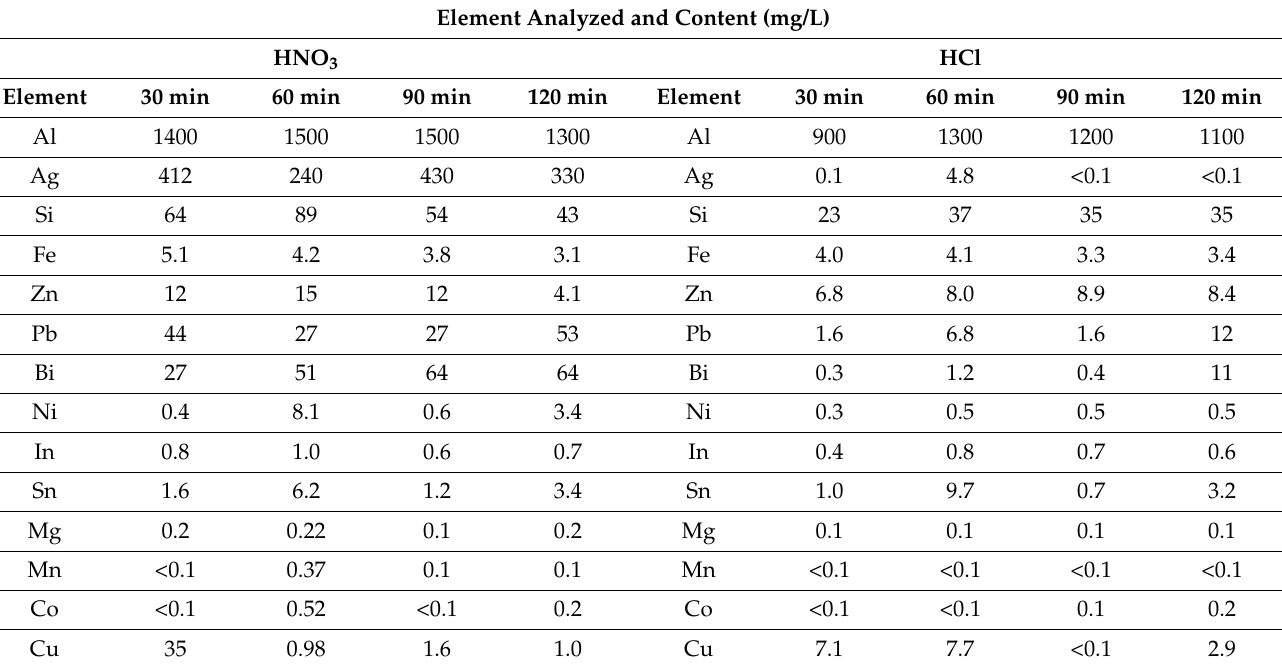
Table 8. ICP-Full Scan analysis results of the filtered solution—time. Element Analyzed and Content